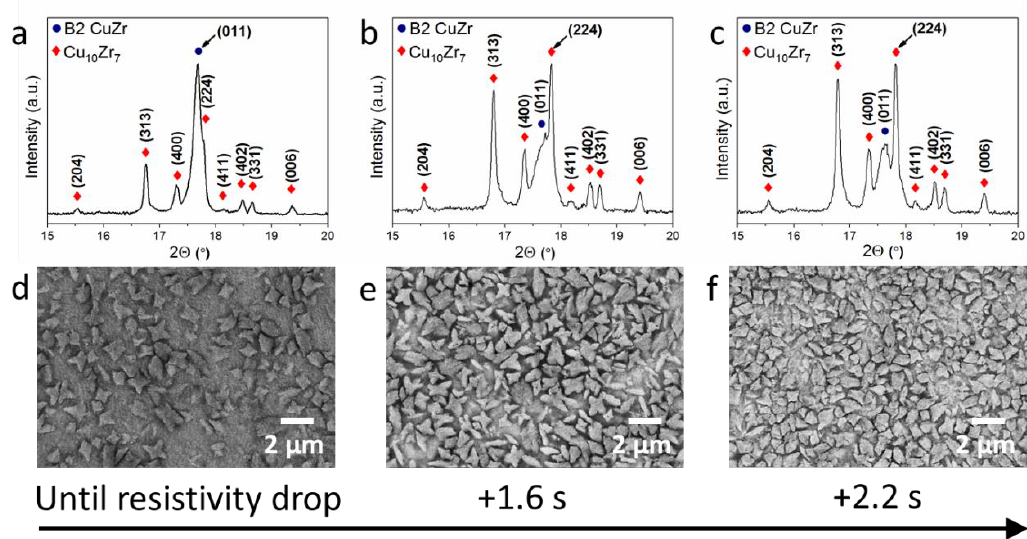
Figure 3. Effect of annealing time on the microstructure of flash annealed Cu 47.5 Zr 47.5 Al 5 metallic glass. X-ray diffractograms ( a – c ) and secondary electron micrographs ( d – f ) of the Cu 47.5 Zr 47.5 Al 5 metallic glass samples rapidly annealed by Joule heating at the current density i 3 = 34 ± 5 MA m −2 and different times: ( a , d ) until the resistivity drop; ( b , e ) 1.6 s after the resistivity drop; and ( c , f ) 2.2 s after the resistivity drop. (Figure 3d is adopted from [20]).